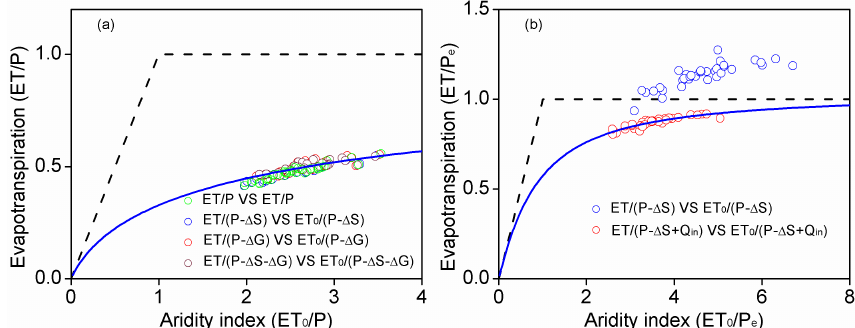
Figure 10. Different presentations of the annual water balance for (a) region I and (b) region III.